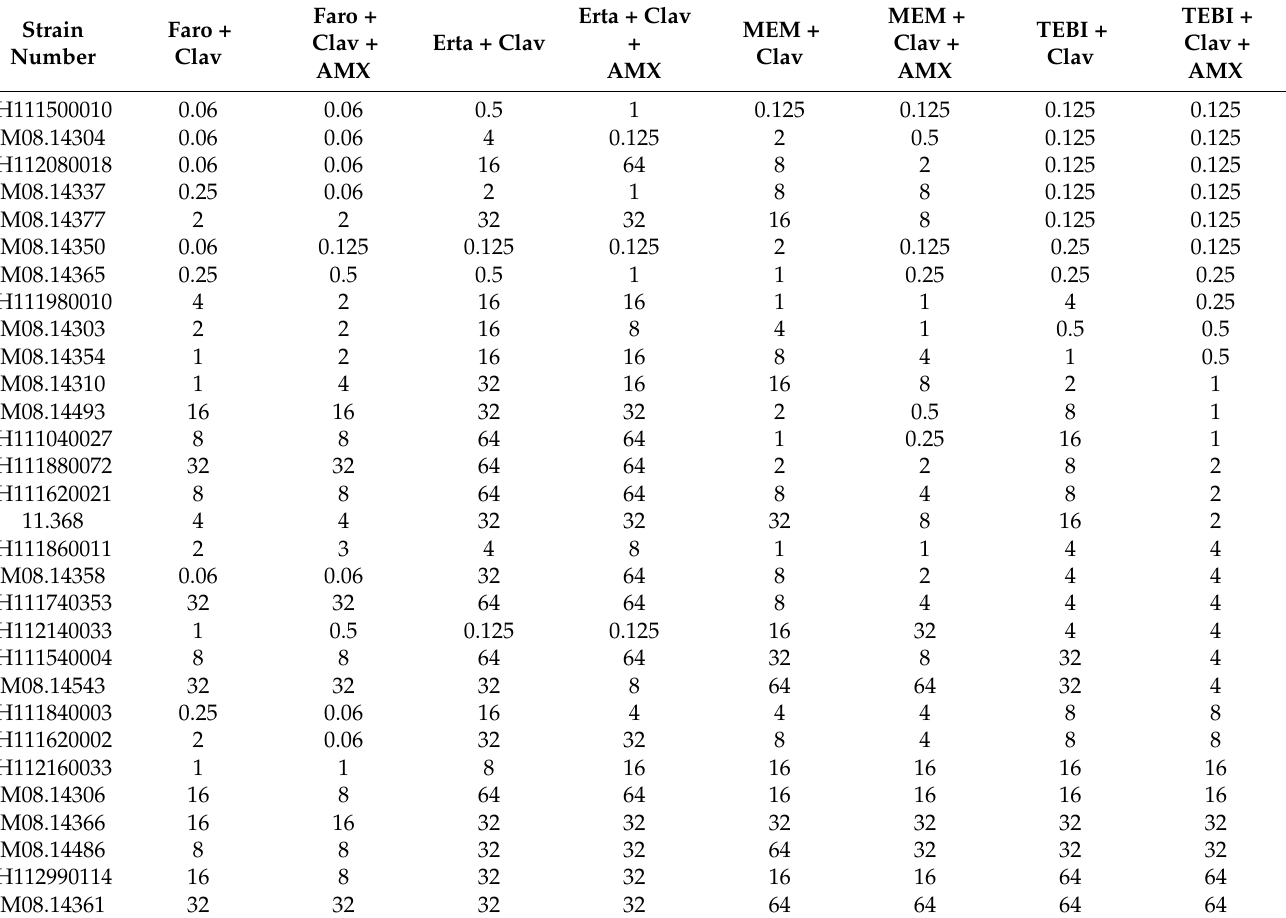
Table 3. MICs of carbapenems (mg/L) in association with clavulanic acid alone as well as clavulanic acid and amoxicillin for strains with resistance to one or more first- and second-line drugs. Clavulanic acid was used at a fixed concentration of 2.5 mg/L, and amoxicillin was used at a fixed concentration of 2 mg/L. Faro, faropenem; Clav, clavulanic acid; AMX, amoxicillin; Erta, ertapenem; MEM, meropenem; TEBI, tebipenem.